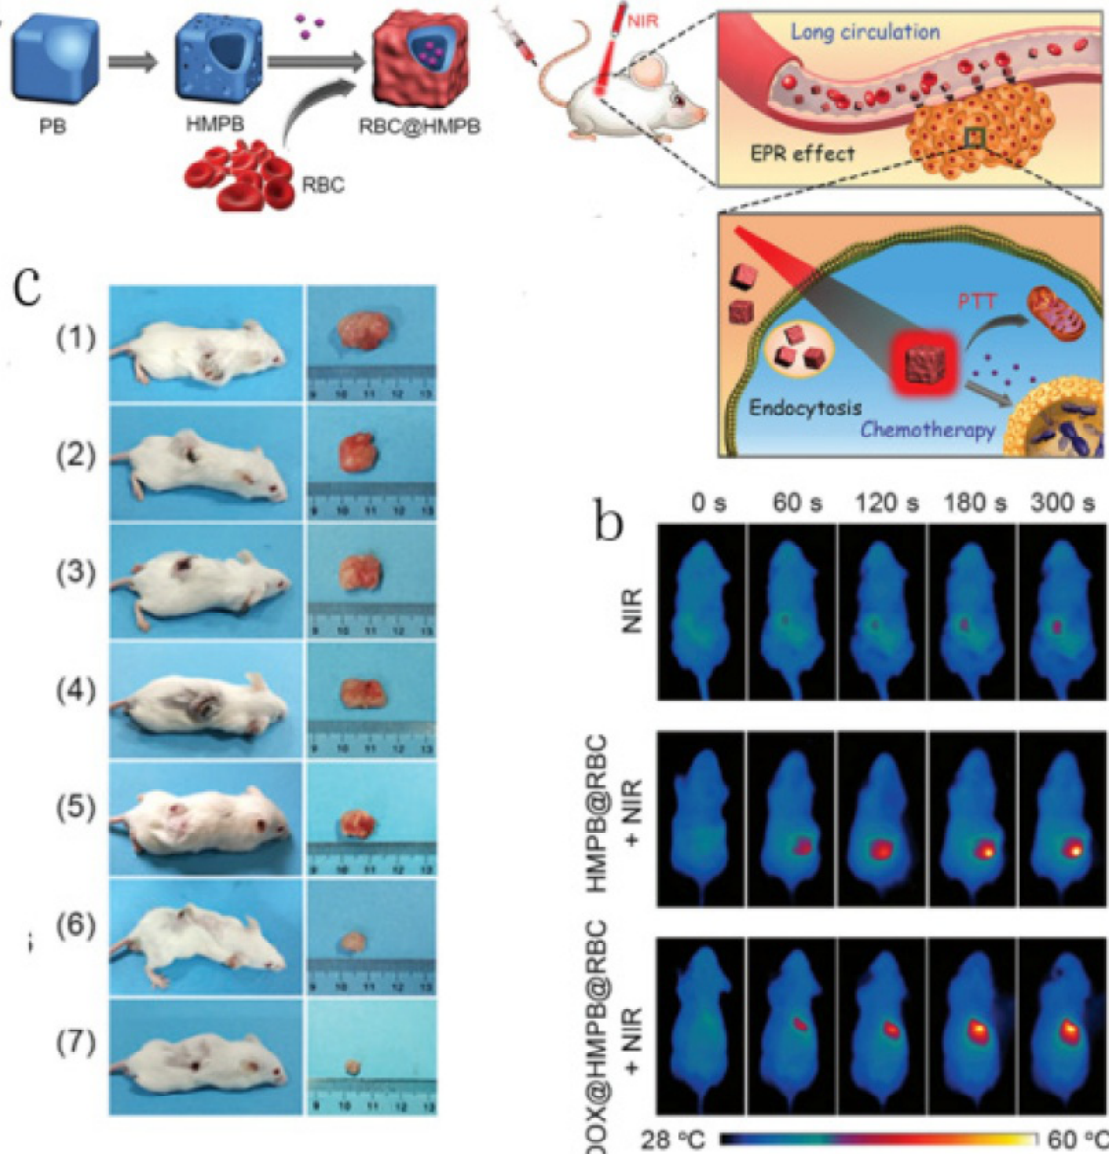
Fig. 7. (a) Illustration of the preparation of drug loaded HMPB@RBC NPs, and the synergistic photother- mal-/chemotherapy of cancer;(b) Infrared thermal images of tumor-bearing mice treated with HMPB@RBC NPs and DOX@HMPB@RBC NPs under 808 nm laser irradiation. (c) Photographs of representative mice after different treatments. Reprinted with permission from W. Chen, K. Zeng, H. Liu // Adv Funct Mater